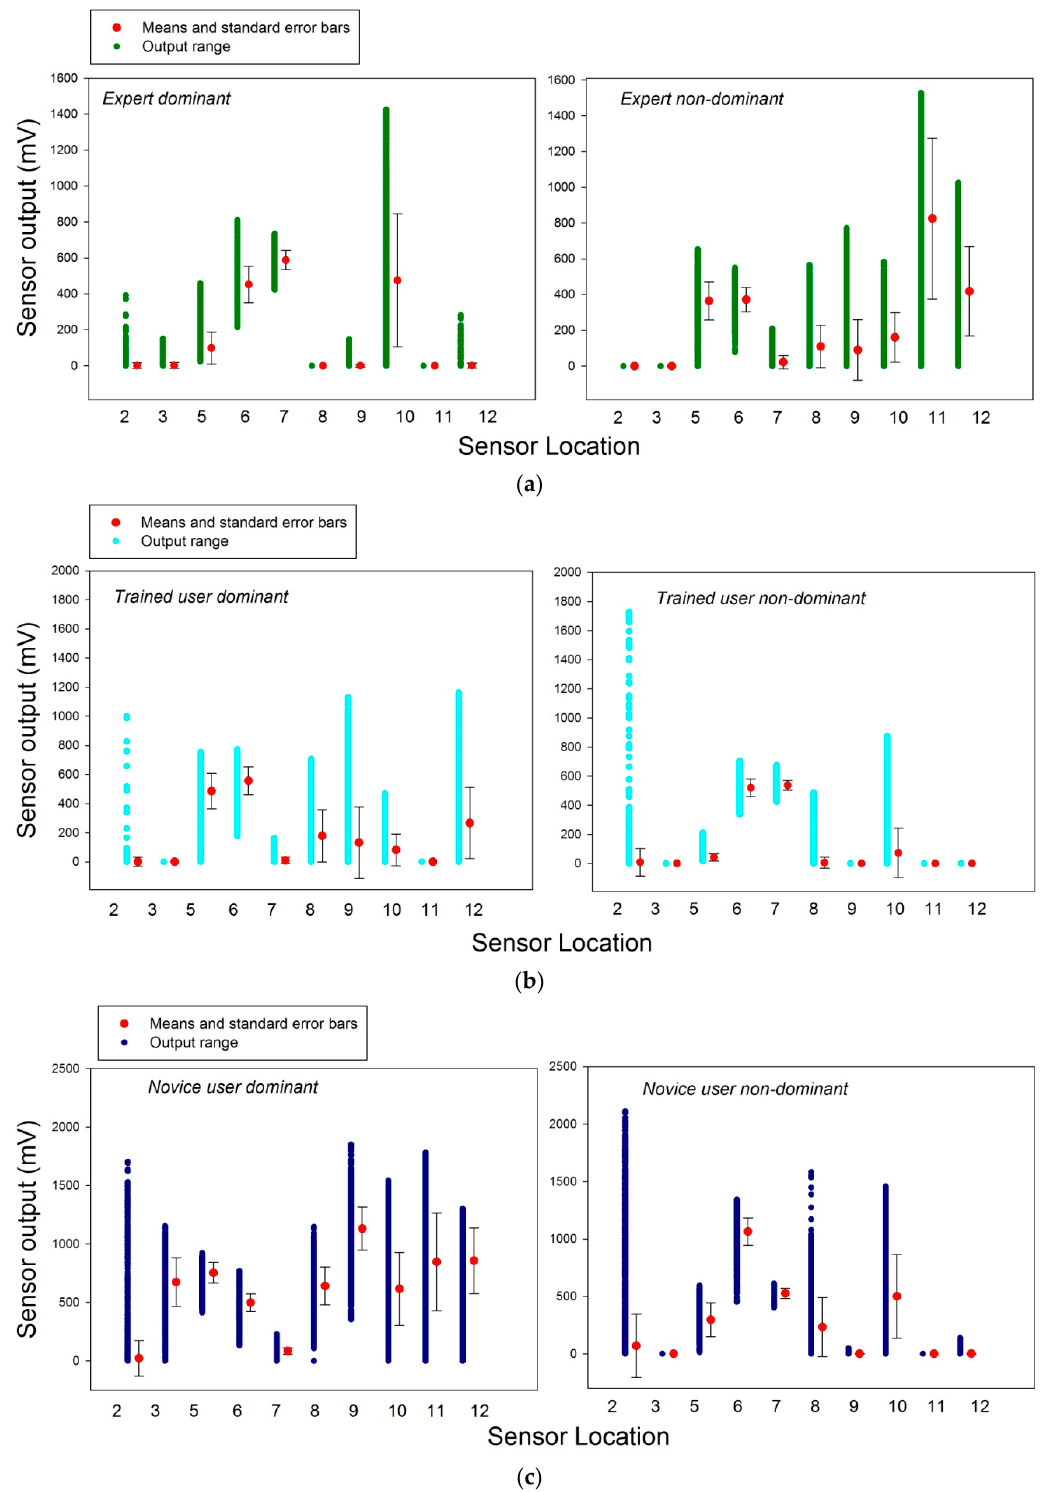
Figure 6. Means, standard errors, and output range between minima and maxima recorded from sensors that generated significant amount of signal output (>10% of signals recorded show non-zero activity) in the dominant and non-dominant hands of the expert user ( a ), the dominant-hand-trained user ( b ) and the novice ( c ).